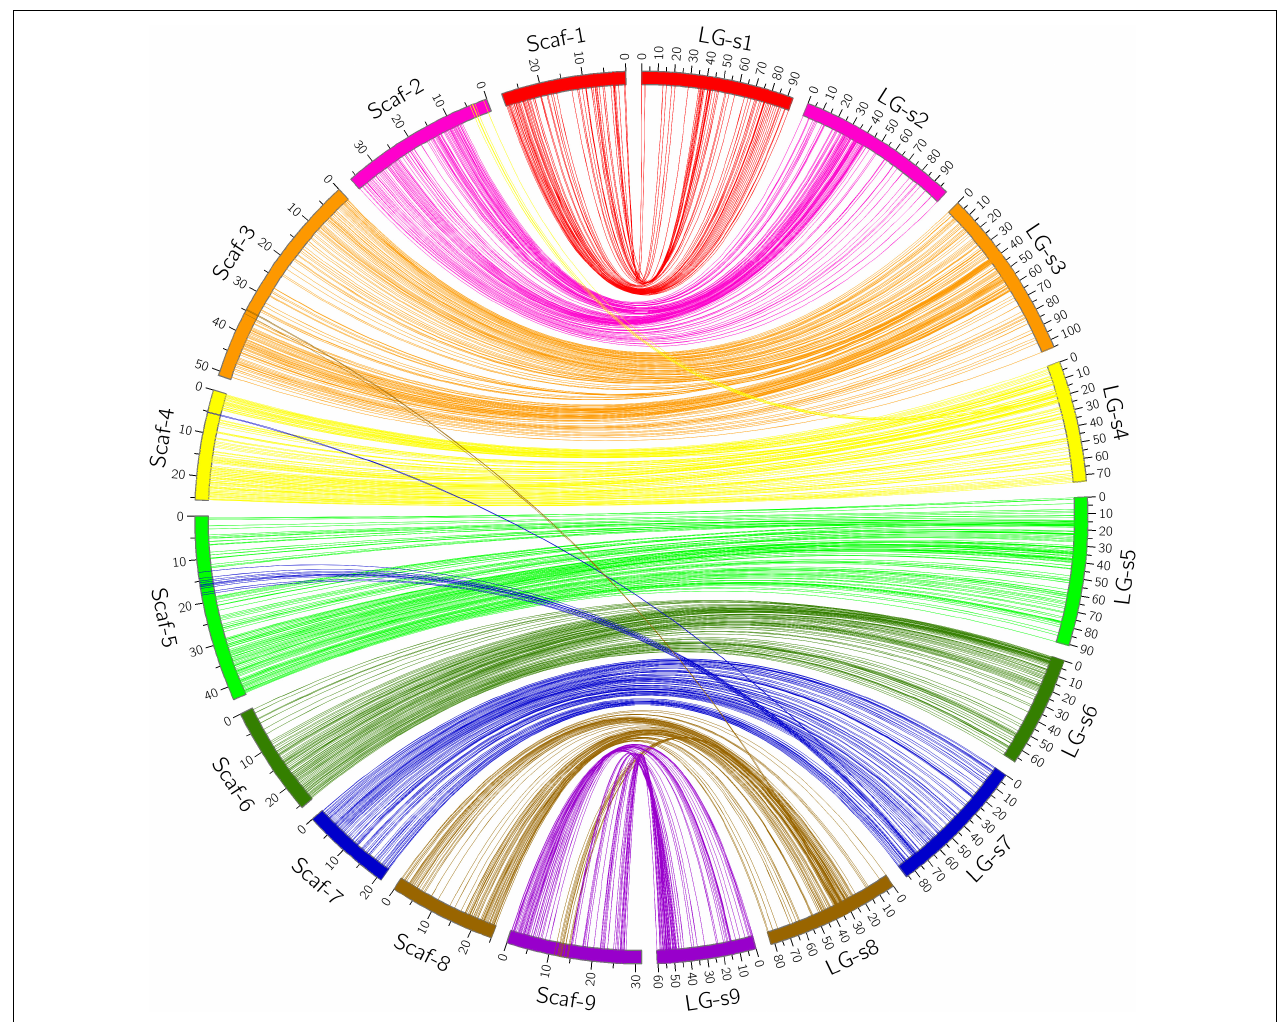
FIGURE 3 | Conservation of synteny and linear order of markers between sweet orange genetic map and Clementine mandarin genome via circle diagram.